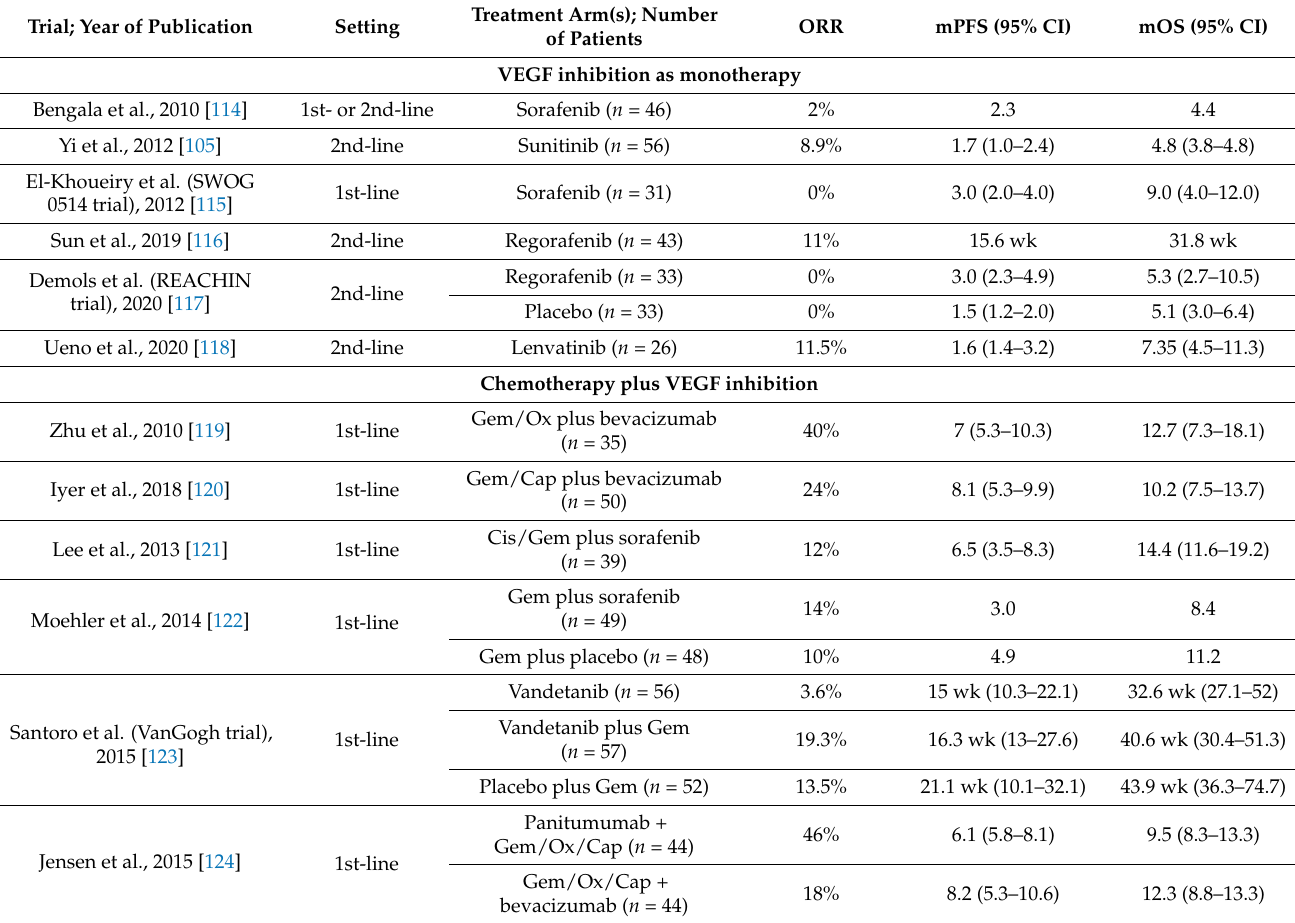
Table 3. Selected clinical trials of vascular endothelial growth factor inhibition in advanced biliary tract